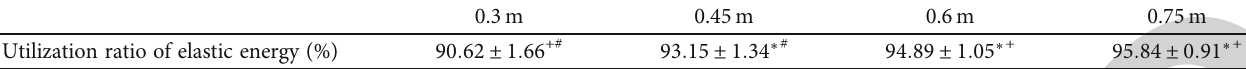
Table 1: The lower limb biomechanical and reactive strength variables during drop jump with di ff erent heights.